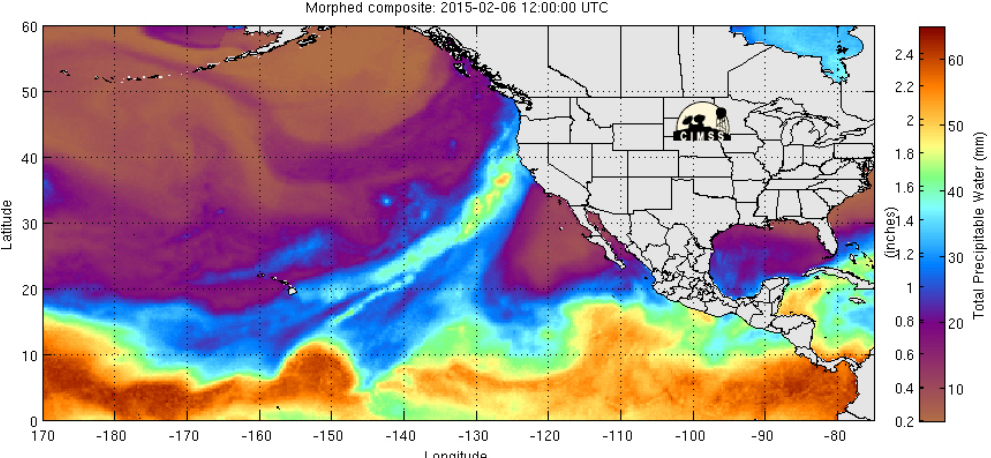
Figure 1. Total precipitable water (shaded, mm) as measured by the SSMI/S composite produced by the CIMSS (Cooperative Institute for Meteorological Satellite Studies) for 12:00 UTC on 6 February 2015, the day when the atmospheric river being investigated made landfall on the Northern California